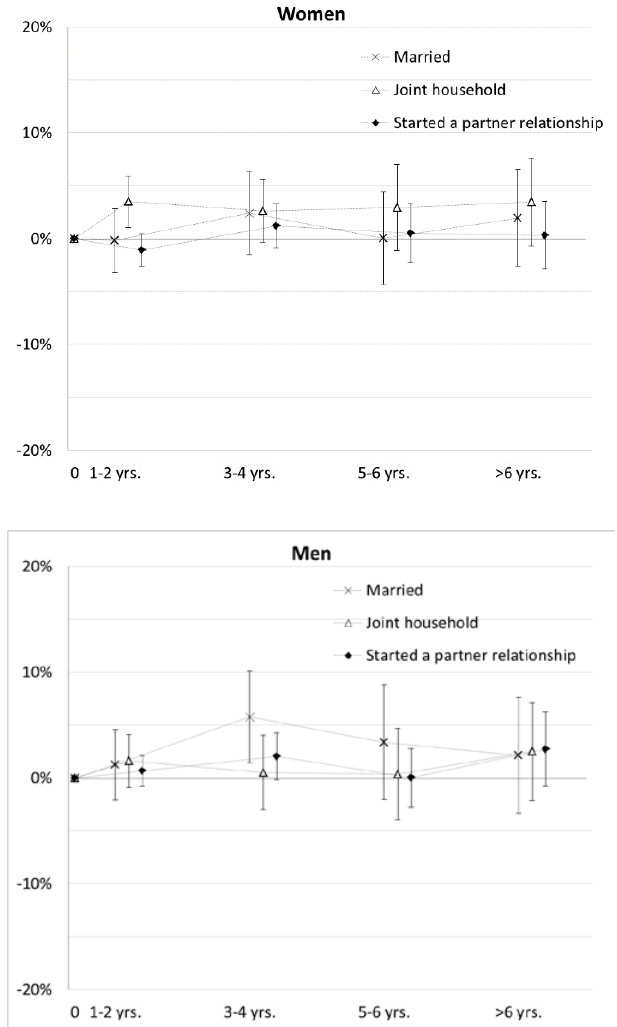
Figure 2 : Time-effects of partner relationships on social isolation (linear-probability models with fixed effects, percentage points and 95%-confidence limits) A) Secondary sphere: disconnectedness from friends and